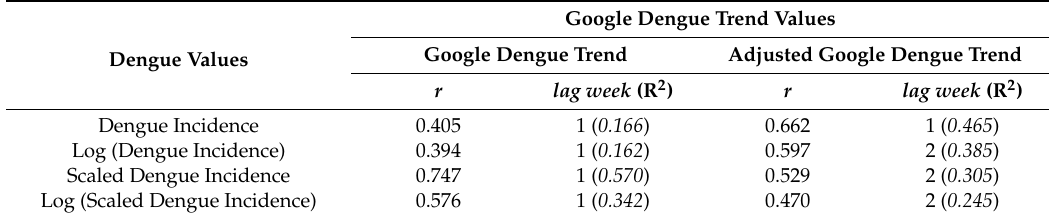
Table 1. Correlation analysis of dengue and Google Dengue Trends (GDT) and its delayed effects (R 2